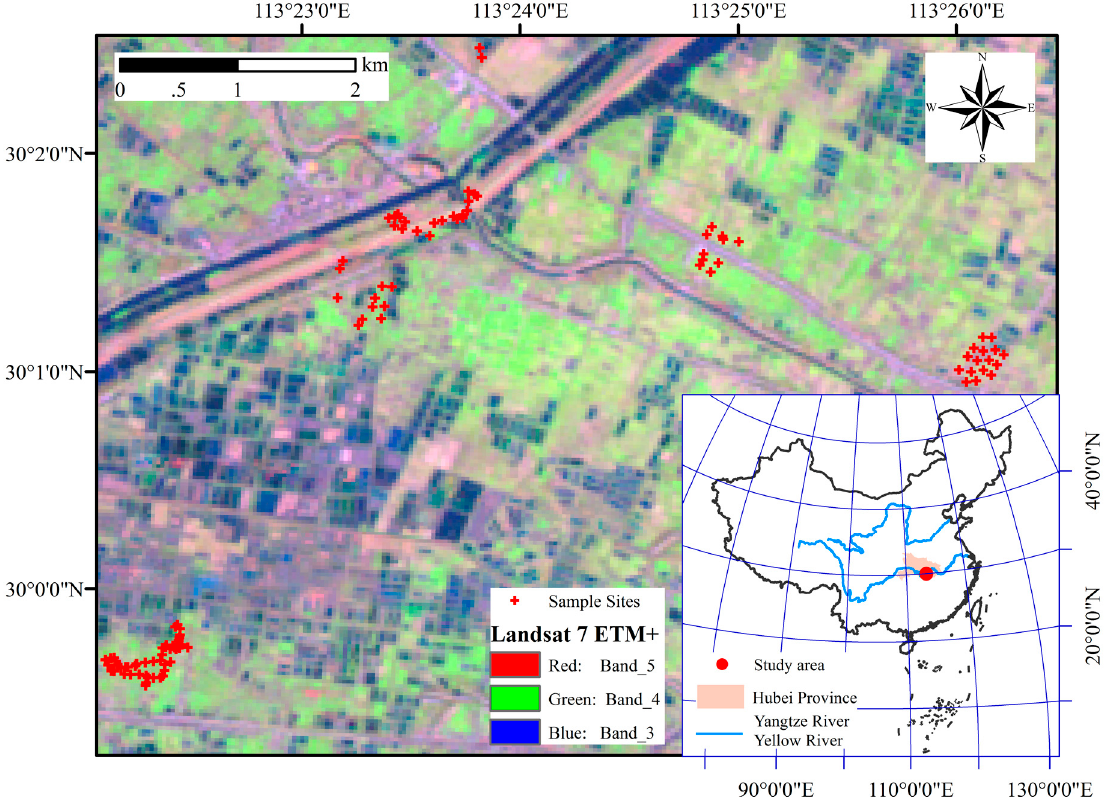
Figure 1. Maps that show the location of the sampled region, the positions of the sampling sites, and the landscapes, as indicated by a Landsat 7 enhanced thematic mapper plus (ETM+) scan line corrector off (SLC-off) image with a composition of bands 4 (red), 3 (green), and 2 (blue).